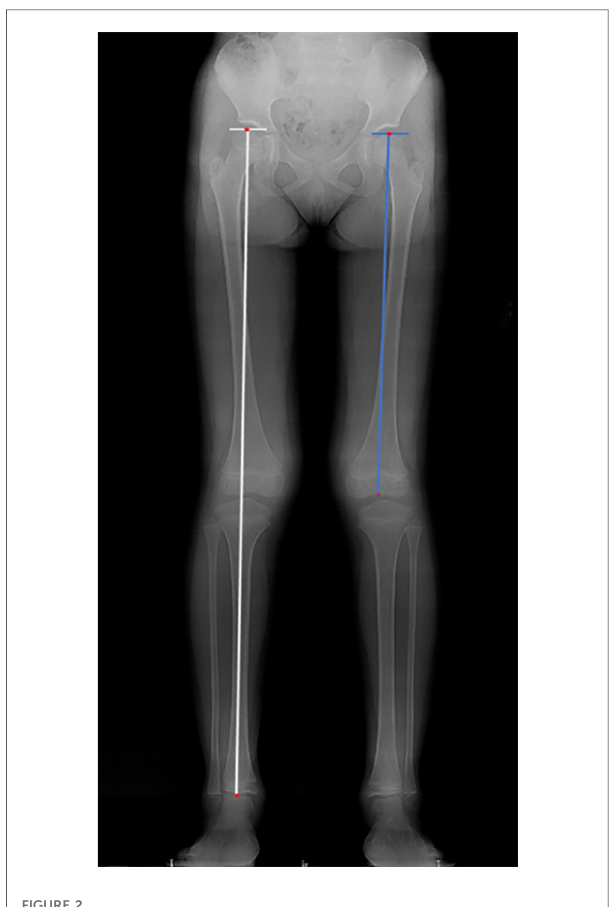
FIGURE 2 Measurement of whole lower limb and femur length. white line: whole lower limb length; blue line: femur length.